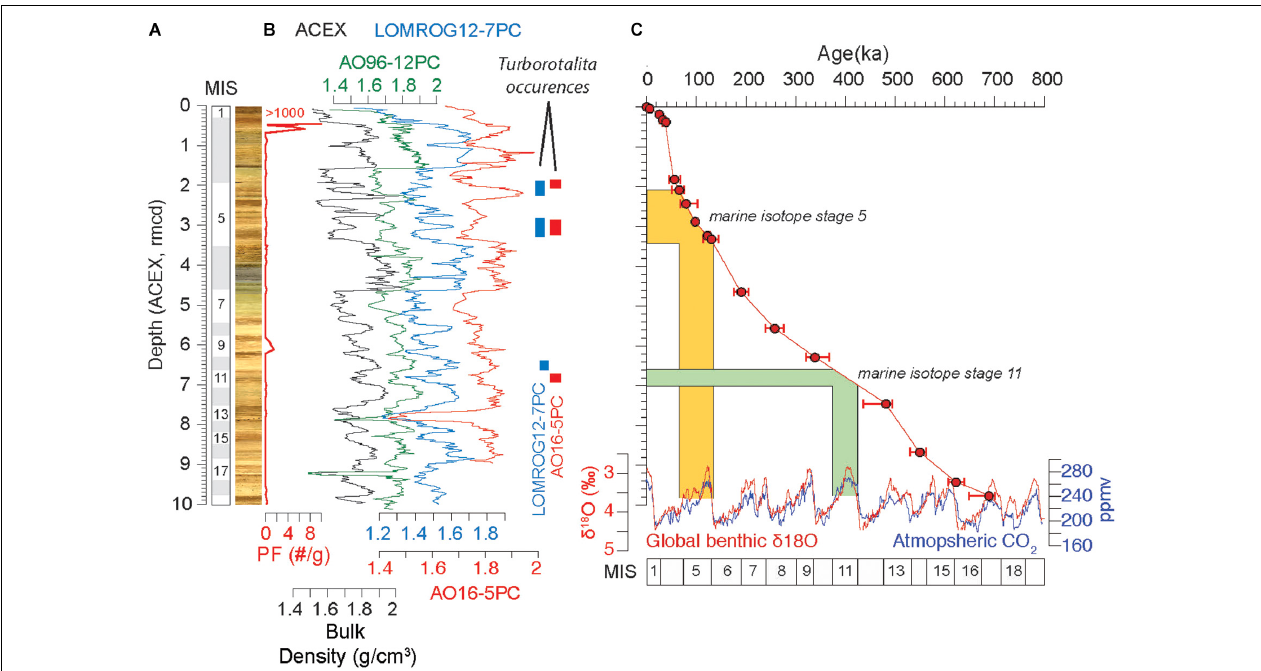
FIGURE 10 | (A) Summary stratigraphy from the upper 10 m of the ACEX borehole showing the composite core image and Planktic foraminiferal (Pf) abundance (individuals per dry gram of sediment) (Eynaud et al., 2009). (B) Bulk density data from ACEX (black), AO96-12PC (green), LOMROG12-7PC (blue), and AO16-5PC (red) are shown. They have been migrated onto the ACEX depth scale based on the stratigraphic correlation illustrated in Figure 5 . The ACEX depth scale is the revised meters composite depth (rmcd) published for ACEX (O’Regan et al., 2008b). The location of the Turborotalita zones in LOMROG12-7PC and AO16-5PC are highlighted. (C) Age model for the upper 10 m of the ACEX borehole (O’Regan et al., 2008b) highlighting the interpreted depth intervals spanning MIS 5 and MIS 11. Global benthic oxygen isotope record and MIS boundaries are from Lisiecki and Raymo (2005). Atmospheric CO 2 concentrations are from a compilation of Antarctic ice core records (Lüthi et al., 2008). Two occurrences of Turborotalita in the LOMROG12-7PC and AO16-5PC appear to be stratigraphically coeval during MIS5, while the earlier occurrence in AO16-5PC appears older (MIS 11) compared to LOMROG12-7PC (MIS